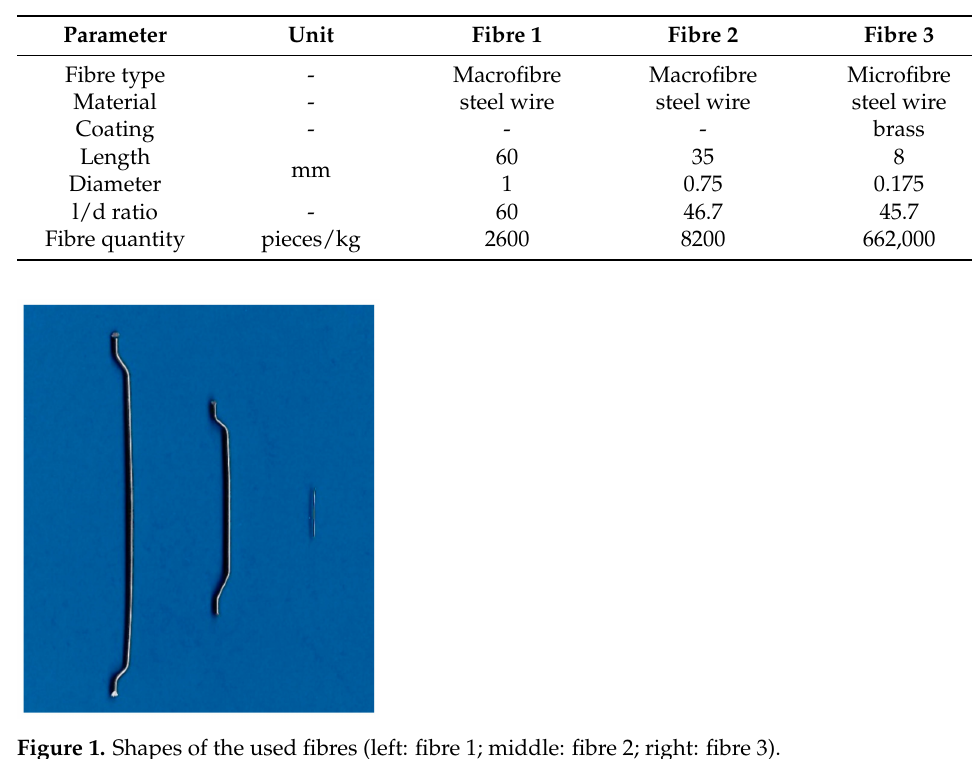
Table 2. Parameters of the used fibres.